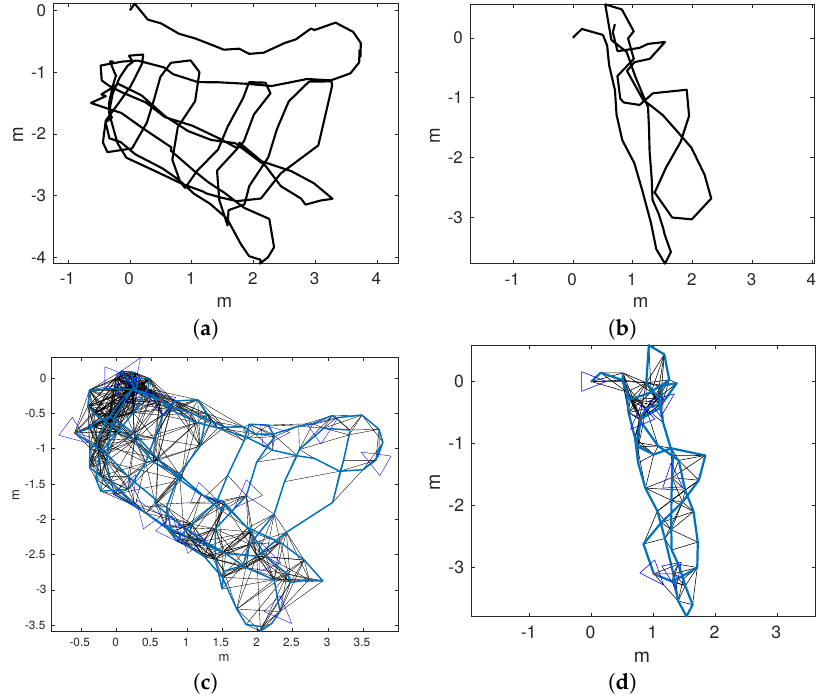
Figure 14. Obtained trajectories for V 3 and V 4: ( a ) Session V 3 odometry, ( b ) session V 4 odometry, ( c ) session V 3 SLAM, and ( d ) Session V 4 SLAM.